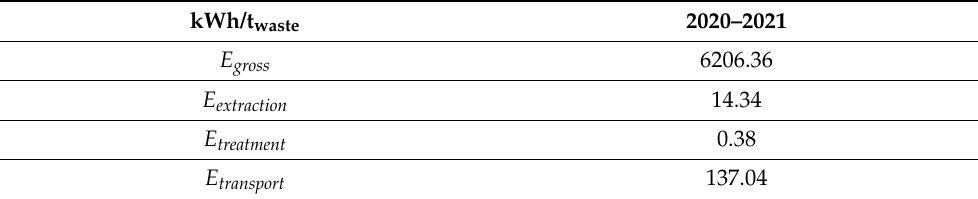
Table 7. Gross energy, extraction energy, treatment energy and transport